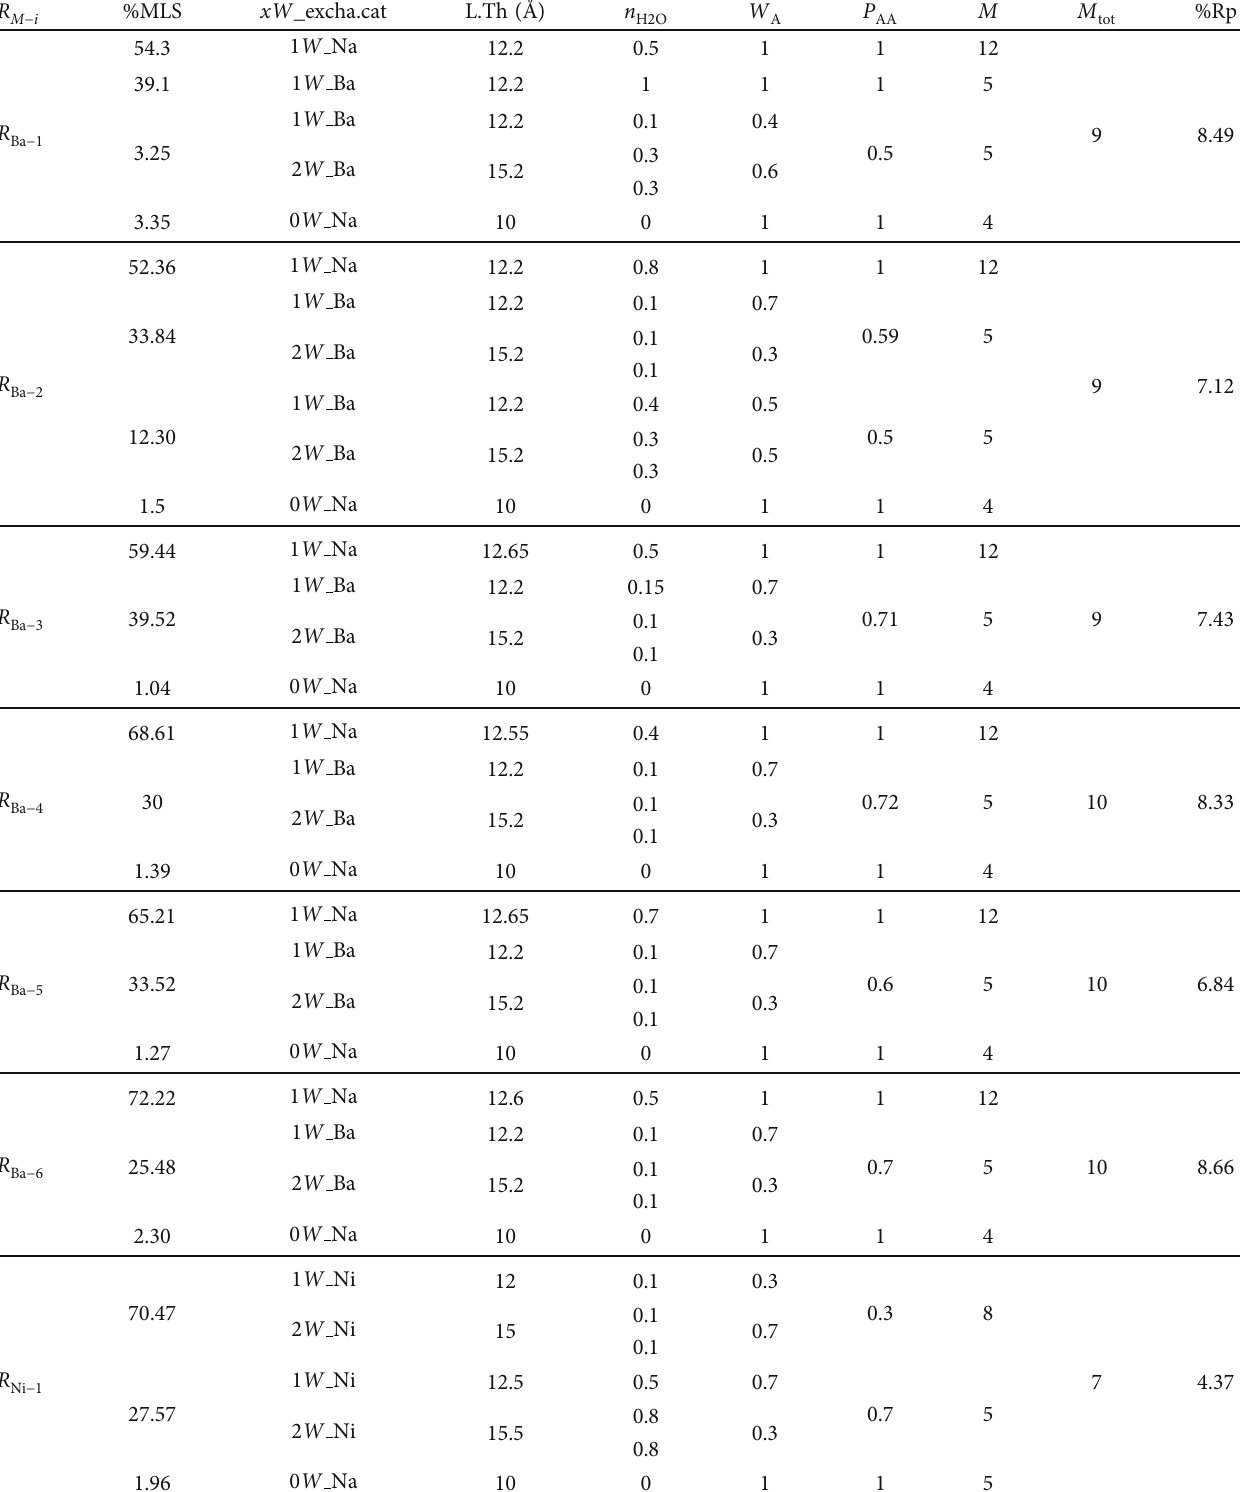
Table 6: Structural parameters of SWy-Ba and SWy-Ni